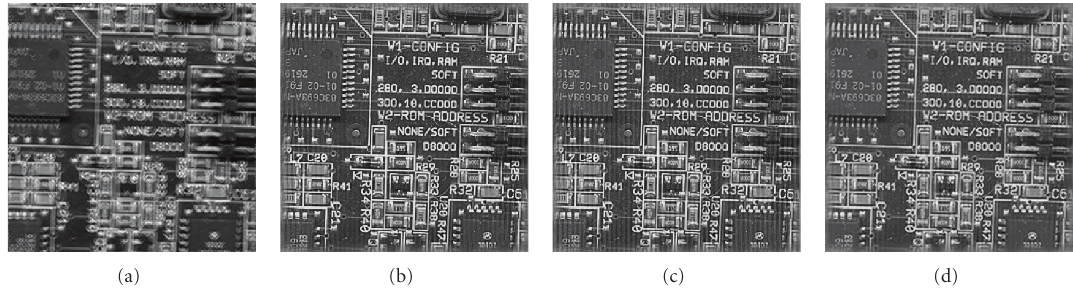
Figure 1: Restoration results in no noise scenario (a) Blurred Image, (b) Wiener, (c) Inverse, (d) CLS restored images.